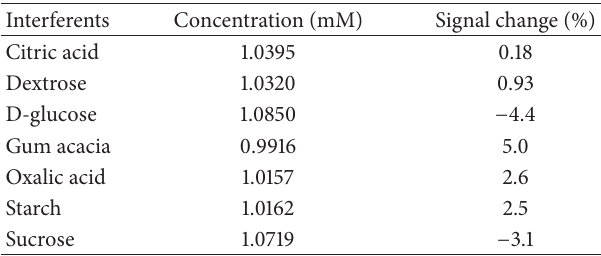
Table 3: Influence of potential interferents on the voltammetric response of 1.0 𝜇 M 2-thiouracil.